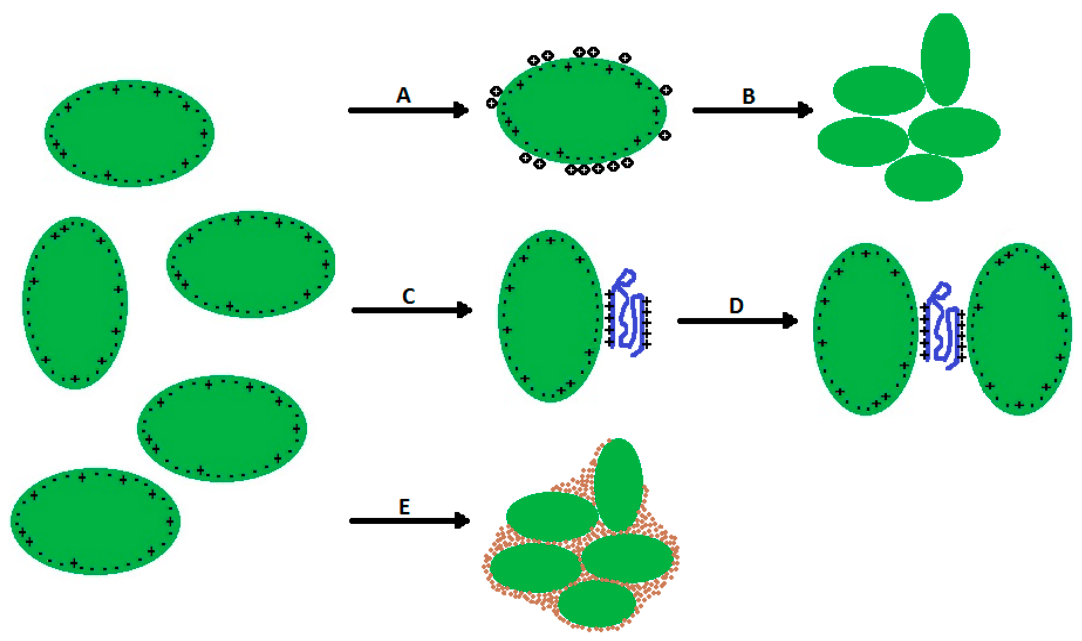
Figure 1. Basic flocculation mechanisms: A —canceling the negative surface charge of microalgae by ion, polymer or colloidal absorption; B —interaction of surface neutral microalgal cells based on the thermodynamic balance of interaction energies; C —charged polymers or colloids locally attach to the surface of microalgae; D —charged polymers or colloids form bridges between two cells; E —entrapment of cells in a massive precipitate.